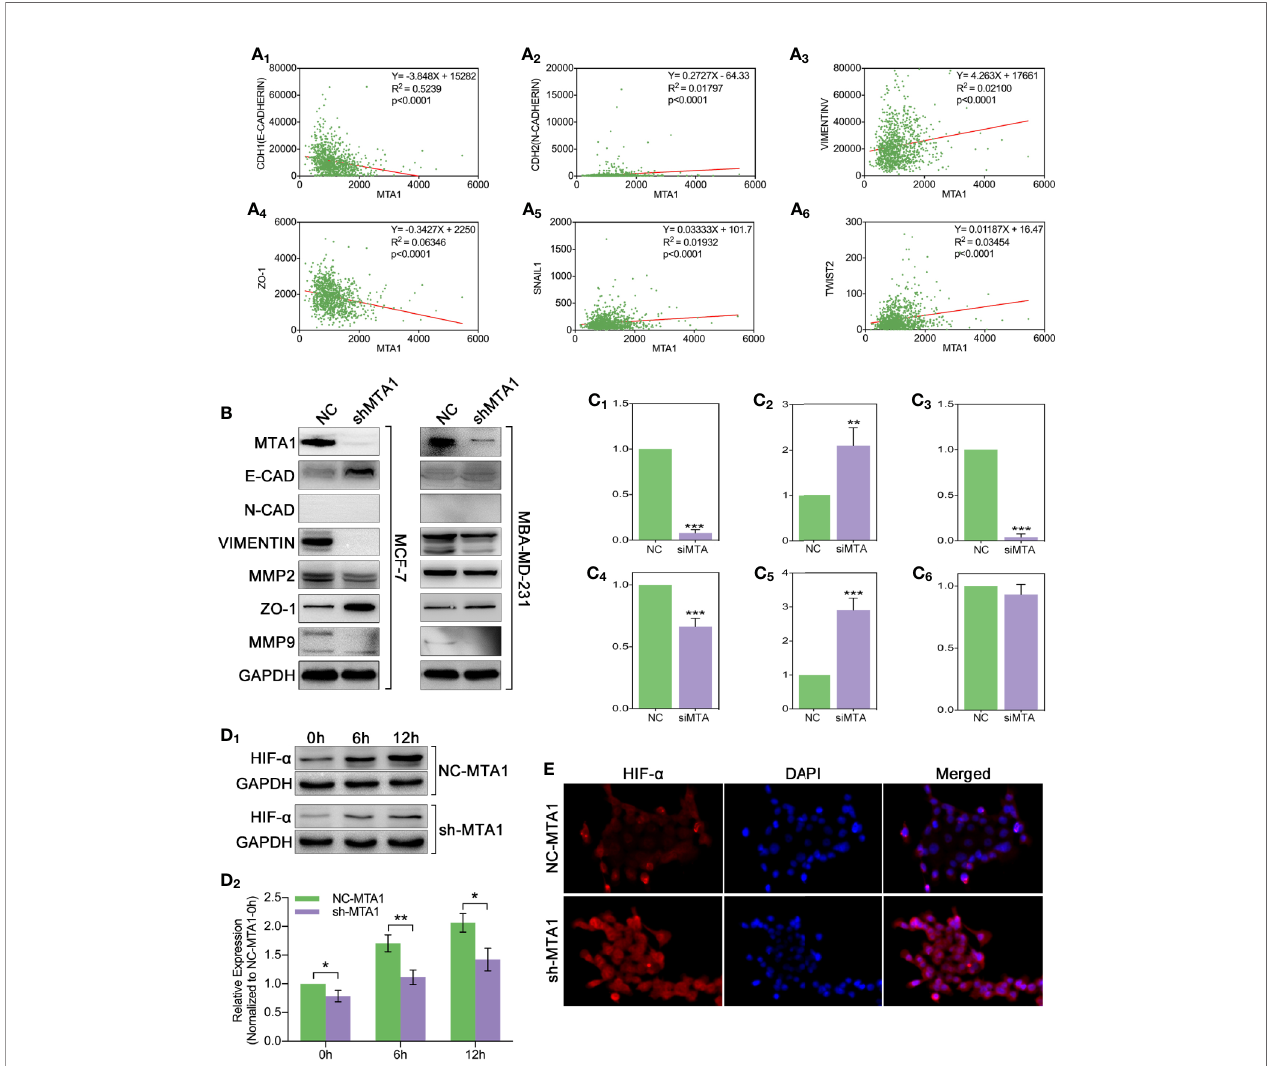
FIGURE 6 | MTA1-knockdown down-regulates the EMT and EMT-associated HIF- a in MCF-7 cells. (1) Relationship between MTA1 and E-cadherin, N-cadherin, vimentin, ZO-1, snail1 and twist2, data from TCGA (A 1-6 ) . (2) WB assay for EMT-associated protein in MCF-7 and MBA-MD-231 cell lines (B, C 1-6 ) . (3) sh-MTA1 and NC-MTA1 cell lines of MCF-7 are treated with hypoxia for 0h, 6h and 12h, then detects the HIF- a level by WB (D 1-2 ) . (4) Same treatment as in (3) which followed by IF assay